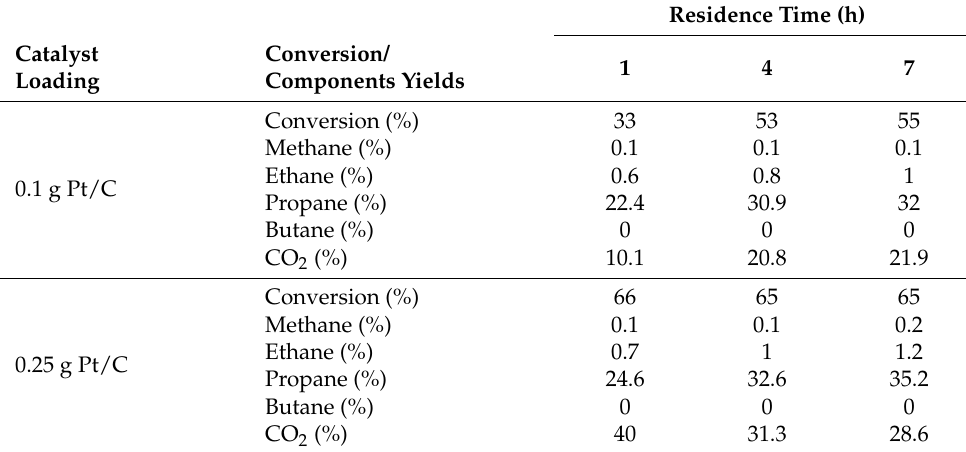
Table 6. Effect of residence time on butyric acid conversion and gas yields using 0.1 g and 0.25 g Pt/C catalyst.